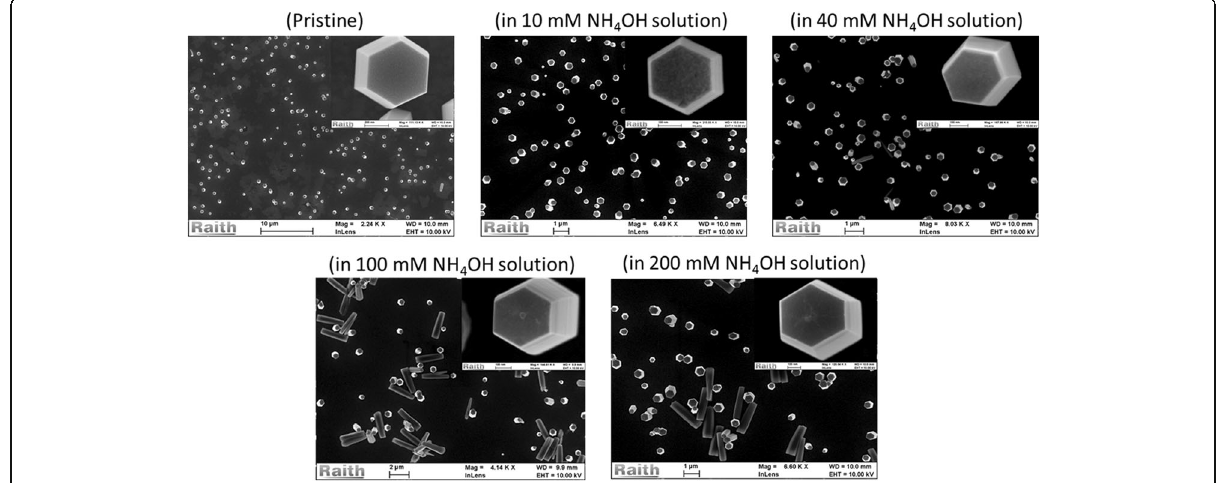
Fig. 3 SEM images acquired from as-grown (pristine) ZnO NWs and post-growth treated NWs in different NH 4 OH concentrations